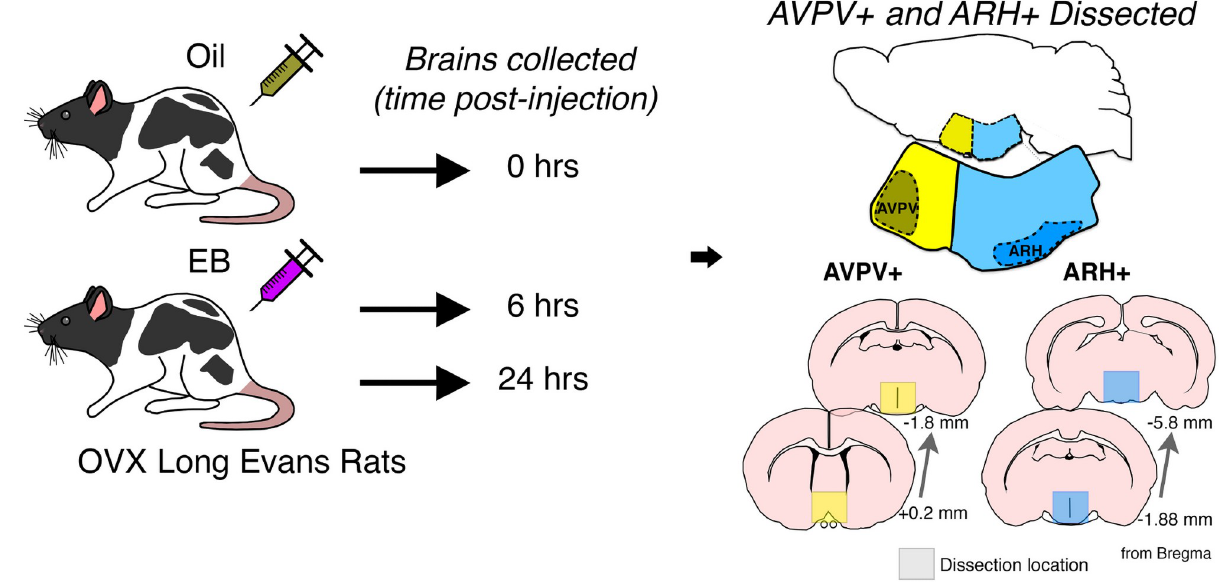
Fig 1. Experimental timeline and location of tissue dissections. Female rats received 5 μ g EB in safflower oil every 4 days to mimic the natural estrous cycle for a total of 3 cycles. 6 or 24 hrs after the last EB injection, brains were collected. Baseline/oil-treated animals received just safflower oil for the 3 cycles and brains were collected immediately after the last oil injection. The AVPV+ and ARH+ were microdissected using the boundaries indicated in yellow and blue, respectively, and snap frozen for subsequent RNA isolation. The dissection locations are indicated in a sagittal view as well as representative schematics depicting coronal sections from Bregma, according to the Paxinos Rat Brain Atlas [24].